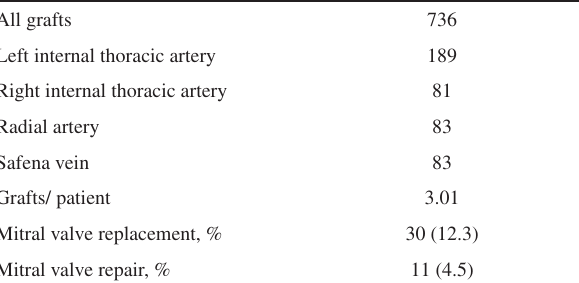
Table 2 - Surgical treatment